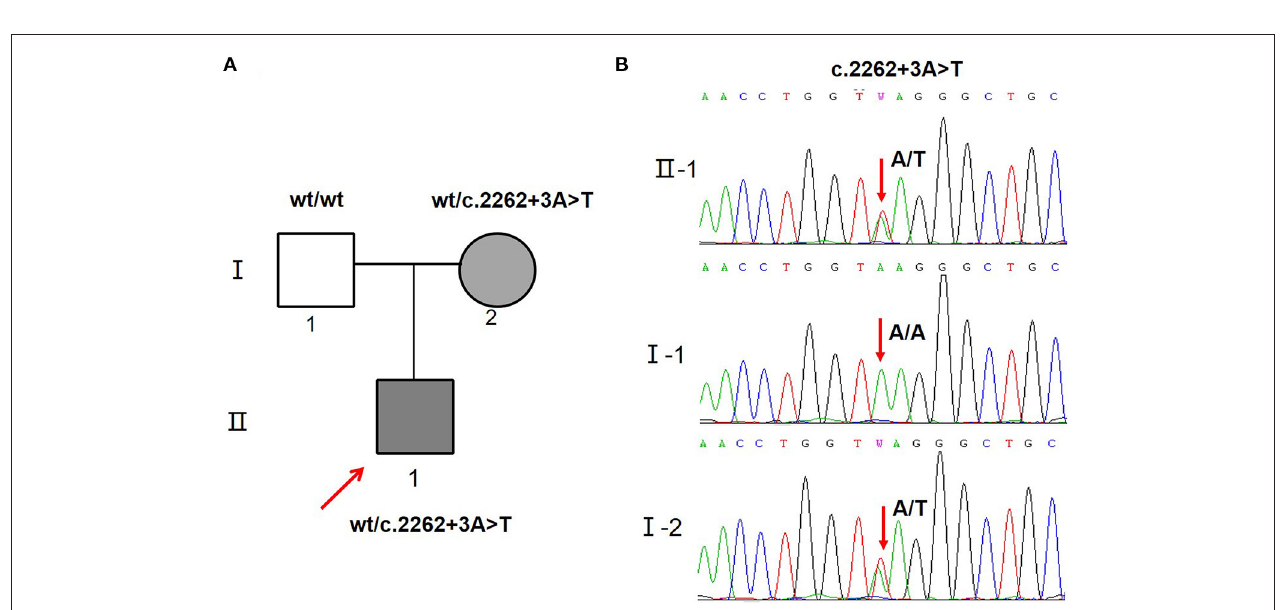
FIGURE 1 | Electrocardiogram (ECG) of the proband. (A) The ECG of the proband showed ventricular tachycardia onset at a cycle length of 280ms. (B) Baseline ECG for proband showing a saddle-shaped ST elevation in leads V1–V3.